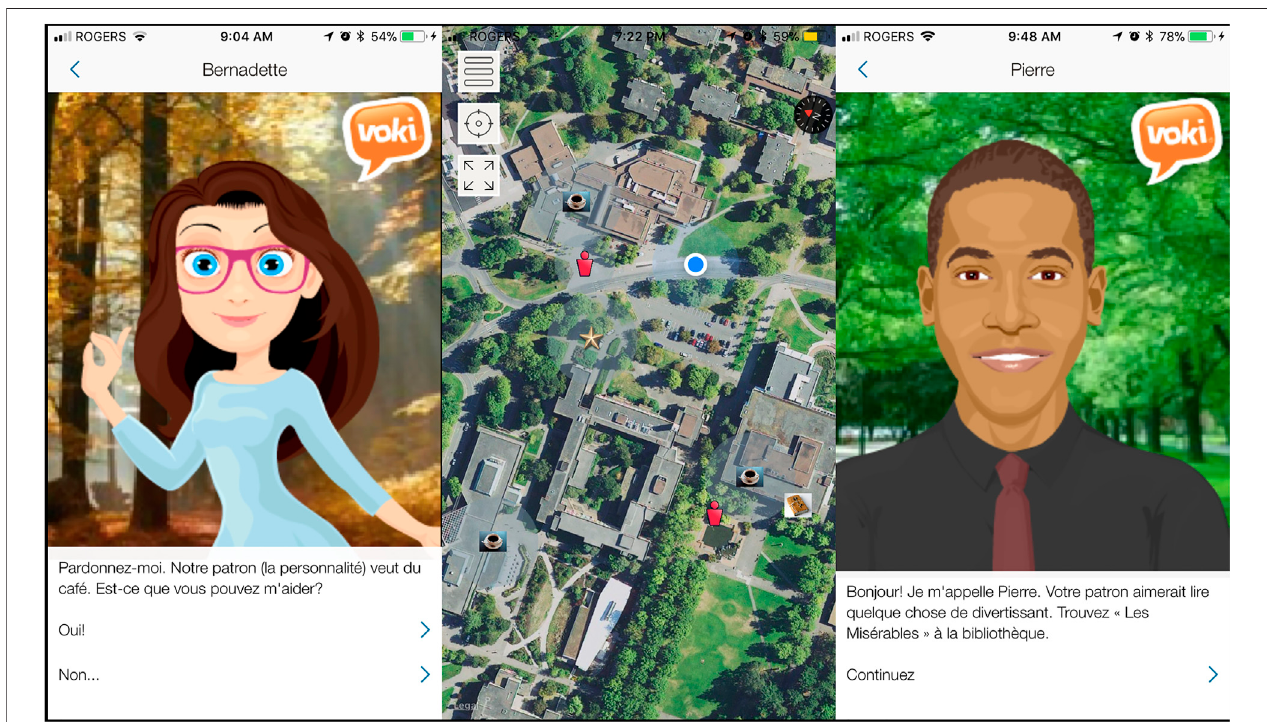
FIGURE 1 | Examples of NPCs and map in Explorez: Left panel (A) – NPC Bernadette “ Trouver le bon café ” Quest, middle panel (B) – player map view, right panel (C) – NPC Pierre “ Trouver un livre ” Quest.